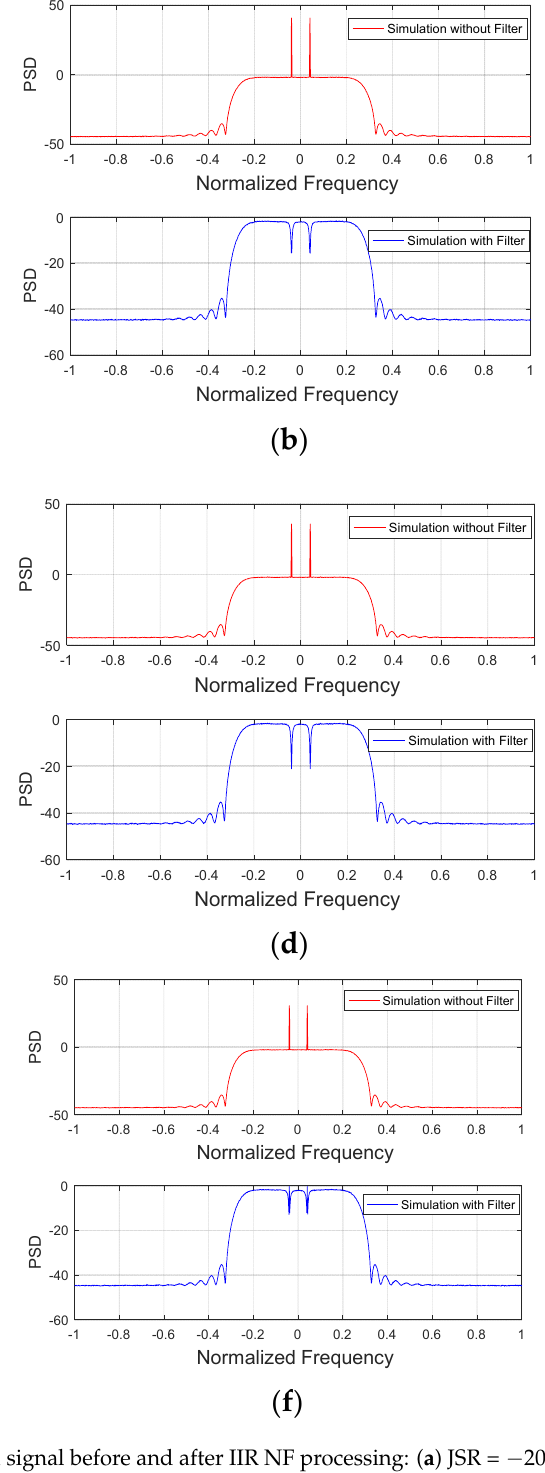
Figure 21. BER vs. JSR, with 𝐄 𝐛 𝐍 𝐨 ⁄ = 20 dB . Figure 22. The estimated optimal k1 vs. JSR.